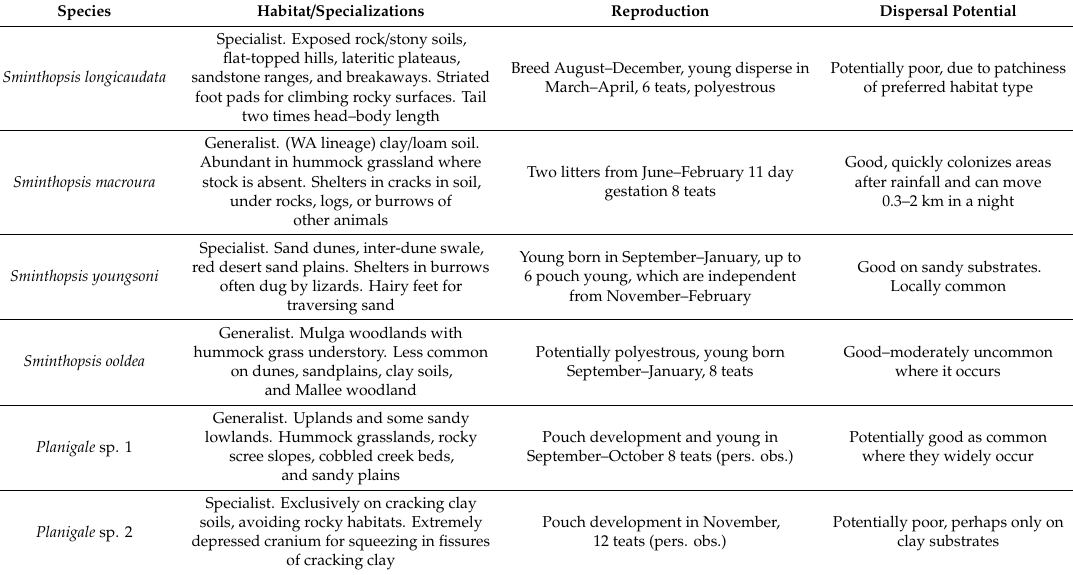
Table 1. Summary of attributes of the six mammal species chosen for this study (data from [29,32]). Species Habitat / Specializations Reproduction Dispersal Potential Specialist. Exposed rock / stony soils, flat-topped hills, lateritic plateaus, Breed August–December, young disperse in sandstoneranges, andbreakaways. Striated March–April, 6 teats, polyestrous foot pads for climbing rocky surfaces. Tail two times head–body length Sminthopsis